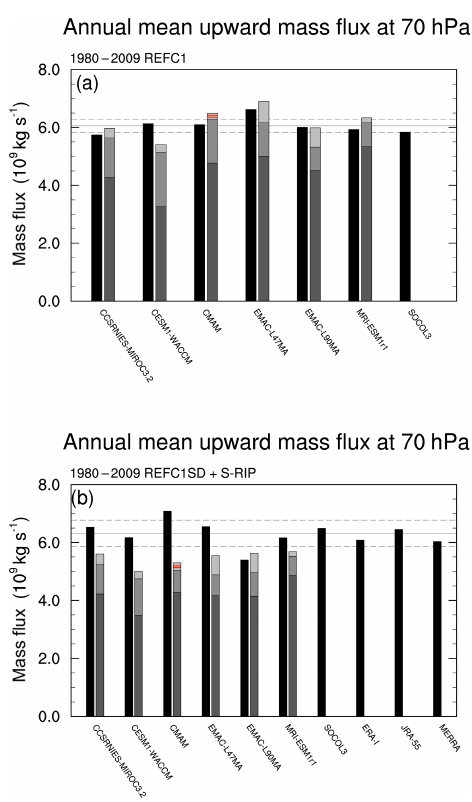
Figure 5. Tropical upward mass flux at 70hPa (left bars) along with downward control calculations (right bars) showing contribu- tions from EPFD (dark grey), OGWD (medium grey), and NOGWD (light grey) for (a) REF-C1 and (b) REF-C1SD and the reanalyses. For CMAM, the NOGWD contributes negatively to TUMF and is indicated with two red horizontal lines inside the lighter grey